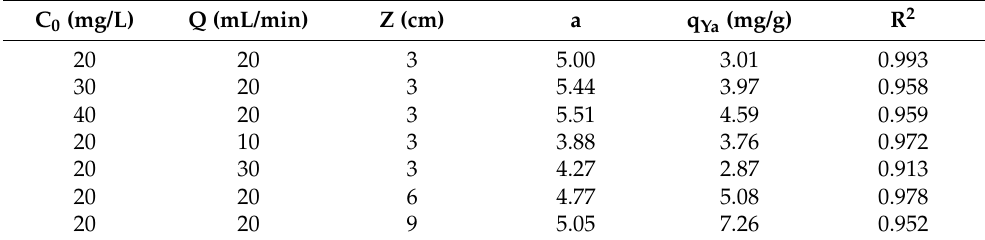
Figure 8. Yan model fitting of F − adsorption by FBC varying ( a ) F − concentration; ( b ) flow rate; ( c ) bed height. Table 4. Calculated fixed-bed parameters using the Yan